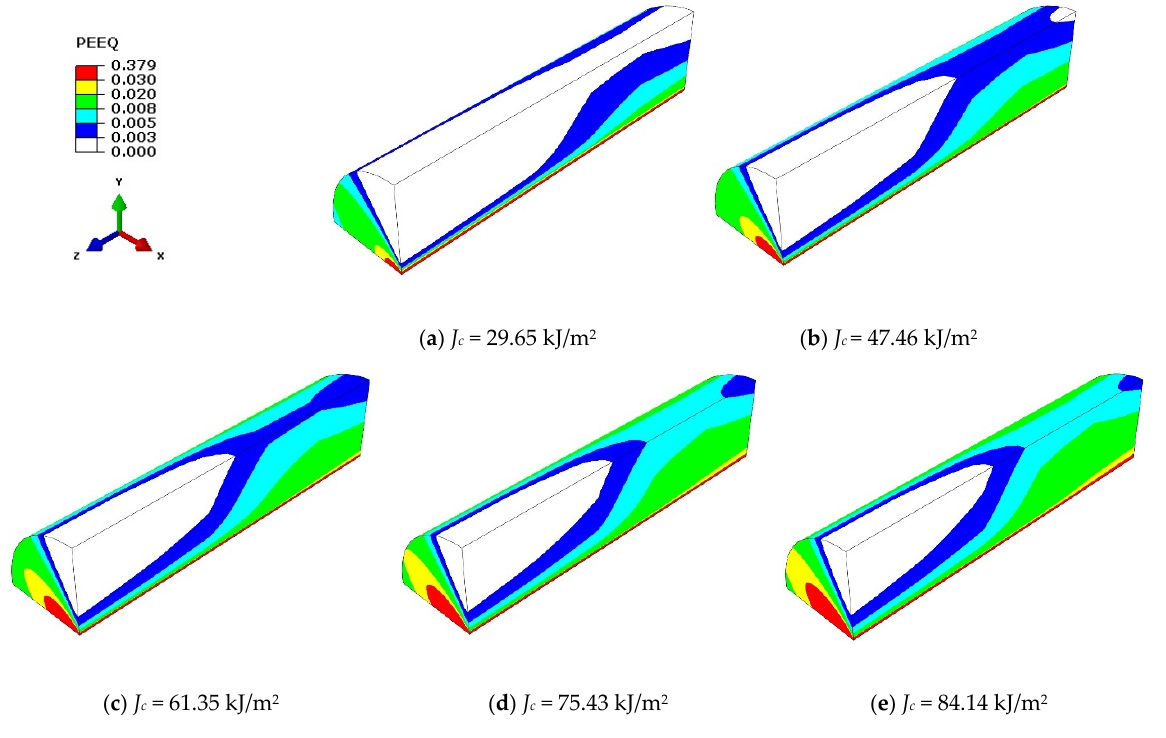
Figure 4. Equivalent plastic strain around crack fronts: ( a ) J c = 29.65 kJ/m 2 , ( b ) J c = 47.46 kJ/m 2 , ( c ) J c = 61.35 kJ/m 2 , ( d ) J c = 75.43 kJ/m 2 , and ( e ) J c = 84.14 kJ/m 2 .